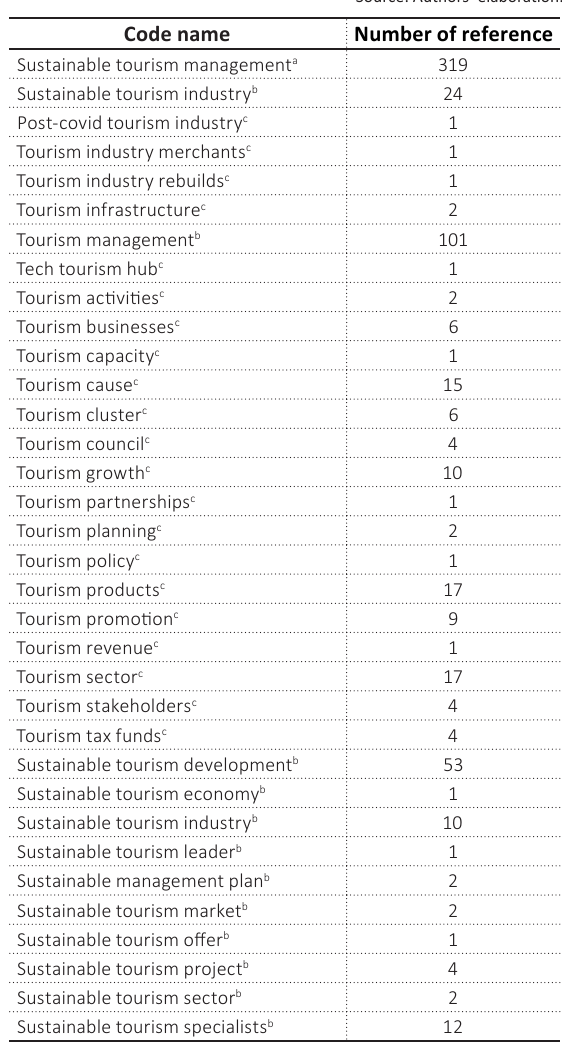
Table 4. The coding process of tourism for sustainable tourism management